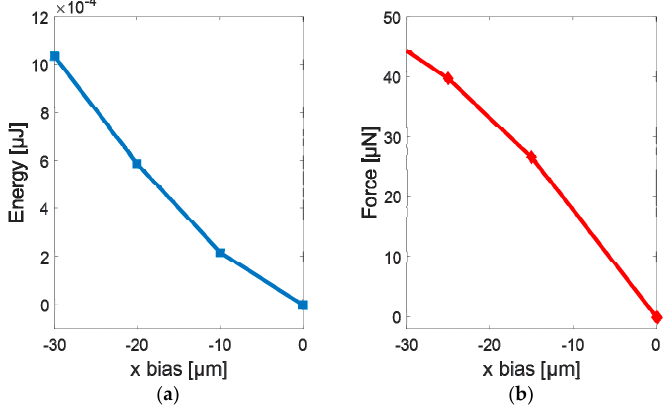
Figure 5. Surface energy and restoring force as the function of x-bias: ( a ) Surface energy of the water meniscus versus x-bias; ( b ) Restoring force driving alignment of microfiber on a hydrophilic–superhydrophobic groove versus